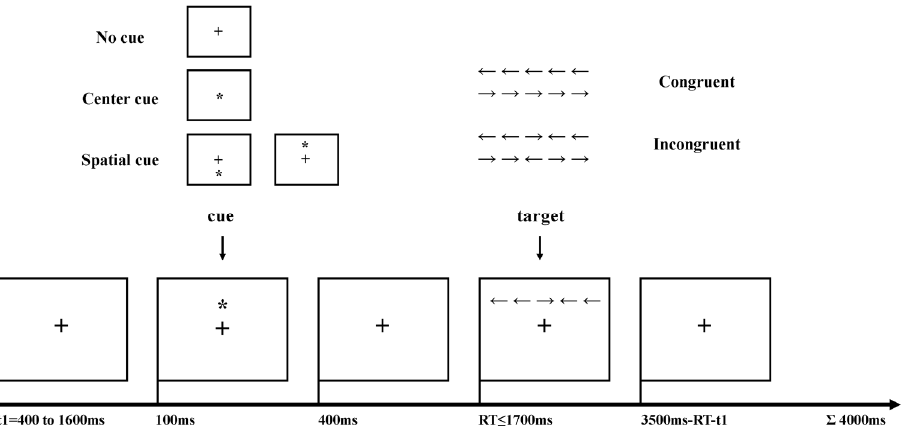
Figure 1. Schematic overview of the Attention Network Test (ANT) adopted in this study. The symbol * indicated the cue, and the symbol + represented the fixation in the center of the screen.